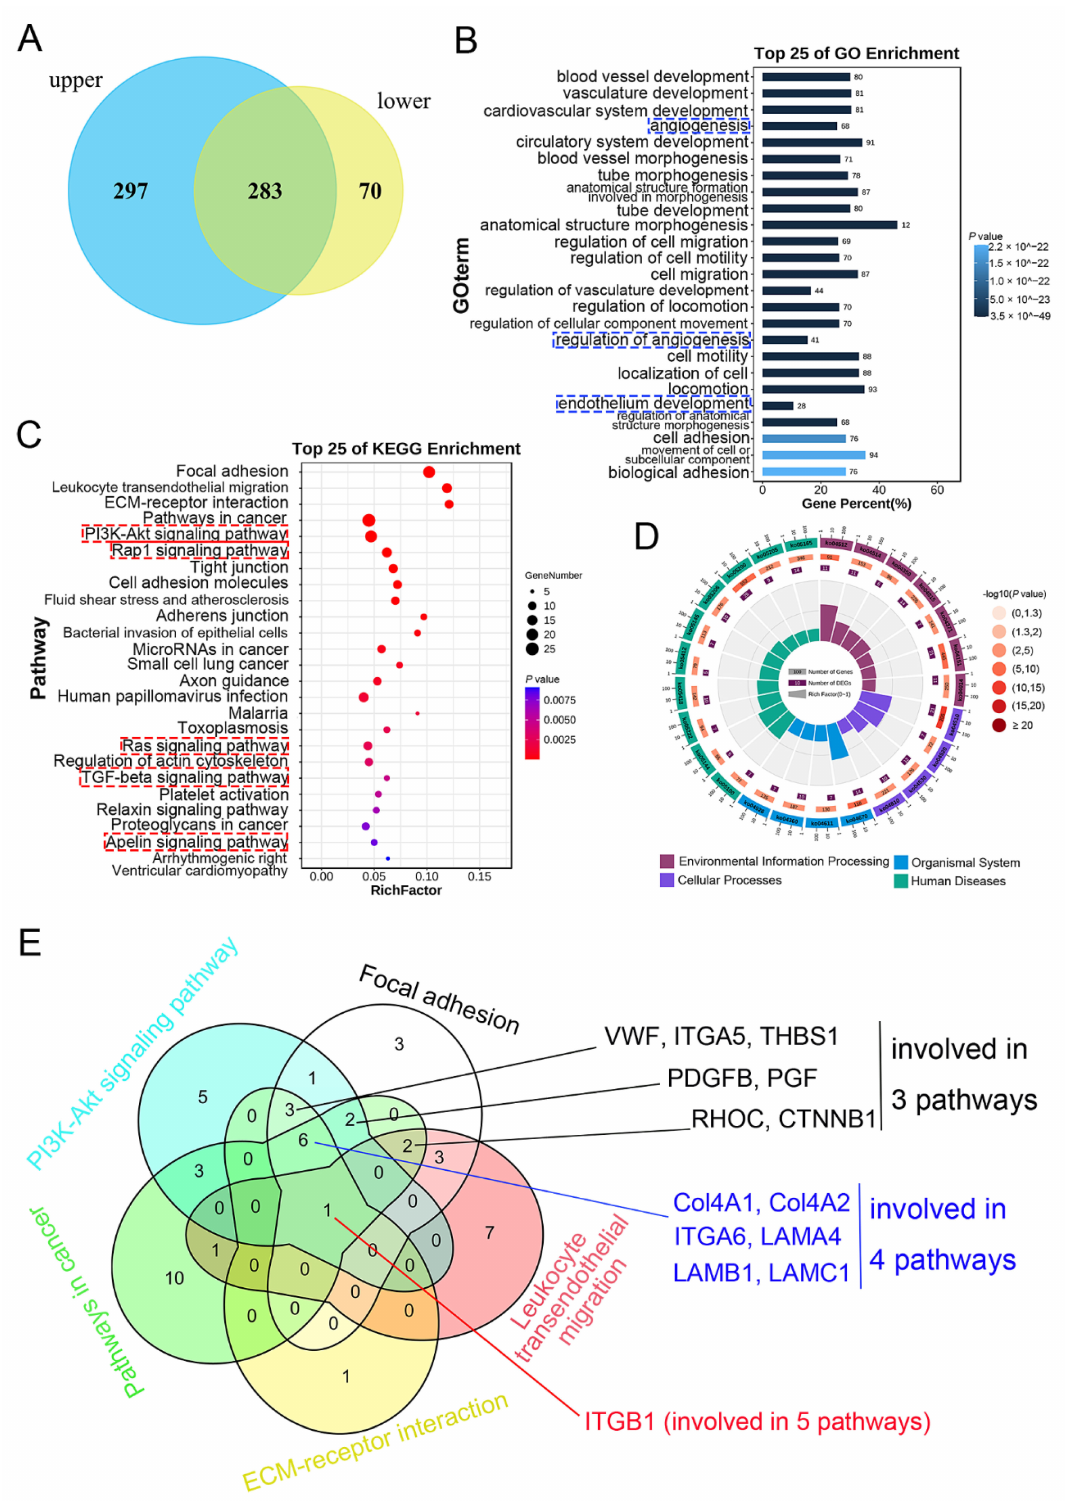
Figure 3. GO and KEGG enrichment analysis of the common DEGs: ( A ) common expressed DEGs, DEGs only in the upper or lower endothelial cells were presented using Venn diagram; ( B ) GO function enrichment; ( C ) KEGG pathway enrichment was shown in gradient; and ( D ) circular diagram; ( E ) common DEGs involved in the top 5 pathways. Blue box: the three functions with the highest rich factors; red box: the critical five pathways with the highest rich